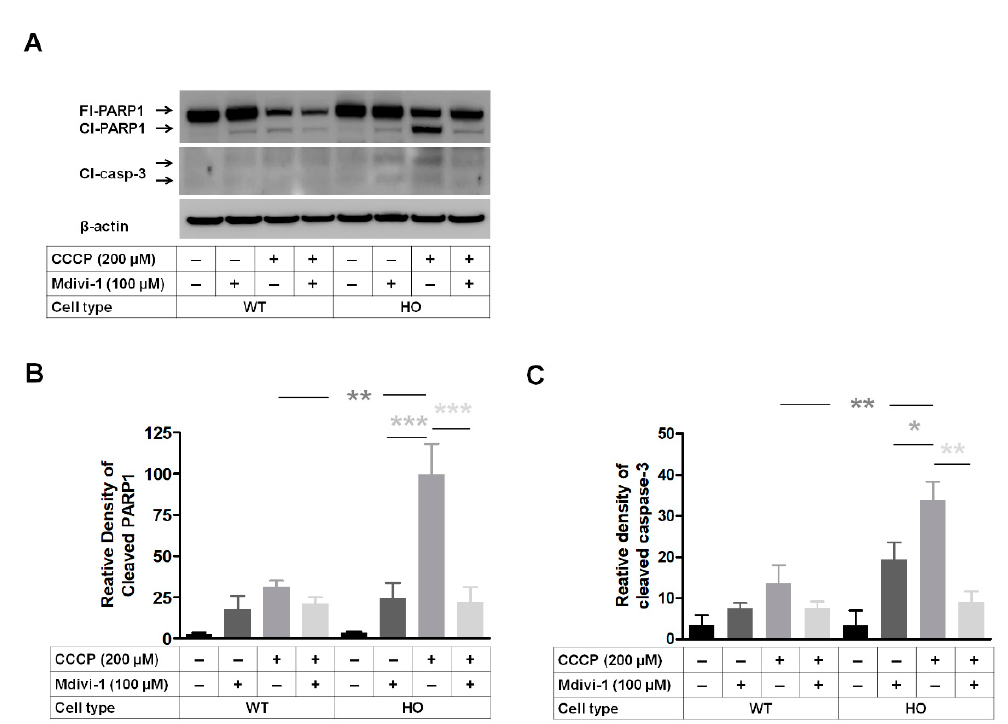
Figure 7. Mdivi-1 (DRP1 inhibitor) prevents CCCP-induced apoptosis of HO corneal fibroblasts. ( A ) WT and GCD2 HO corneal fibroblasts were treated with 100 µ M Mdivi-1 in the presence or absence of 200 µ M CCCP, and Cl-PARP1 and Cl-casp-3 were analyzed by Western blotting. ( B ) Optical densities of the PARP1 bands in ( A ). ( C ) The quantification of cleaved casp-3 levels in WT and GCD2 HO corneal fibroblasts. Western blotting of three independent experiments was performed. Bars represent mean ± SD, * p < 0.05, ** p < 0.01, *** p < 0.001 as compared to control, Student’s t ‐ test.